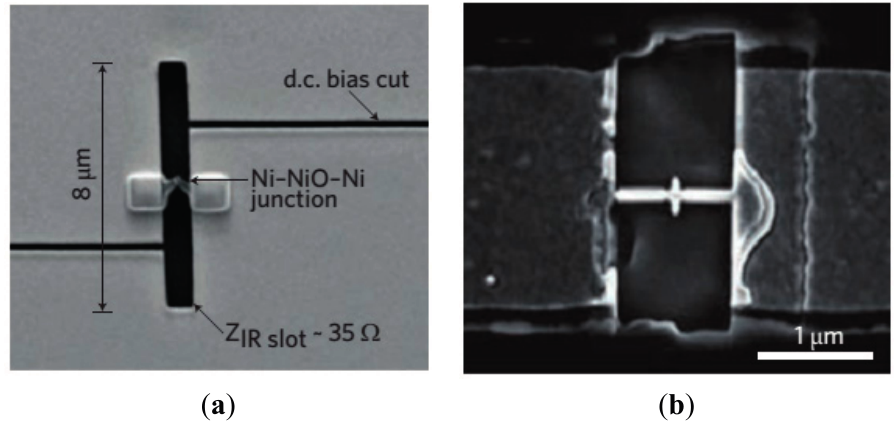
Figure 3. SEM images of ( a ) Slot antenna ( b ) Open-sleeve dipole